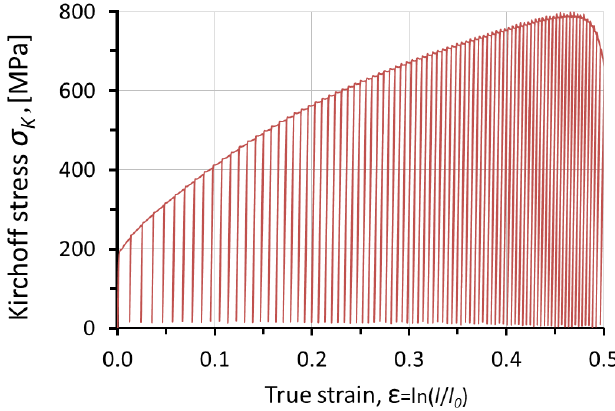
Figure 5. Kirchhoff stress–true strain dependency.